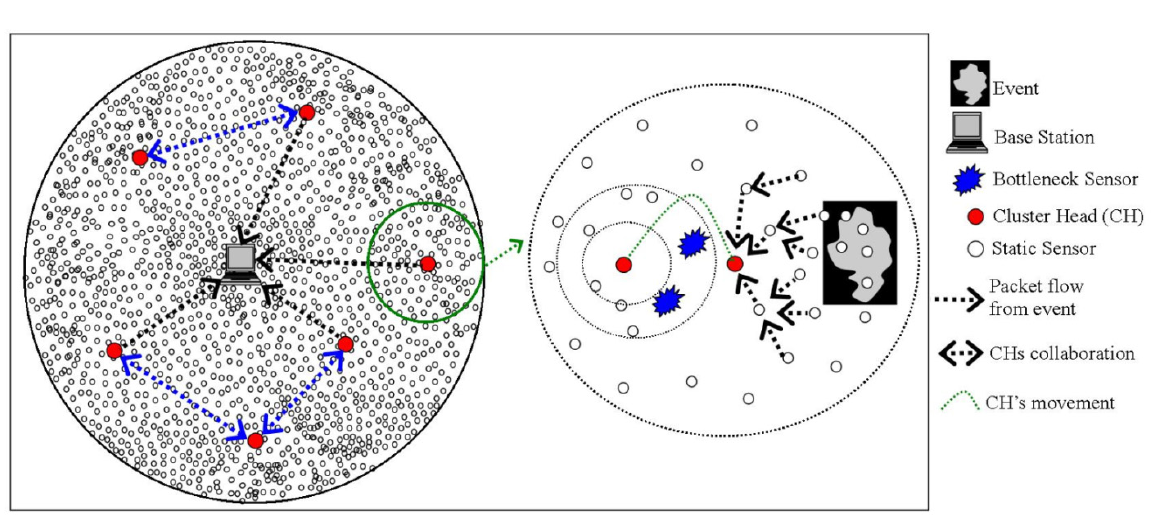
Figure 13. Multiple cluster-heads based mobility model